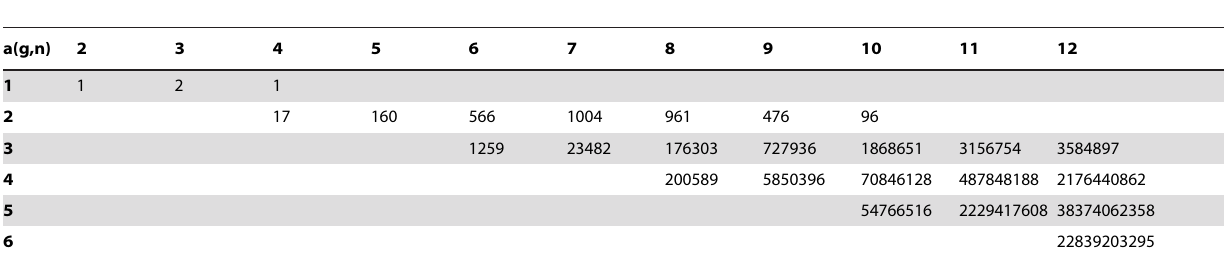
Table 2. Values of a ( g , n ) for n value up to